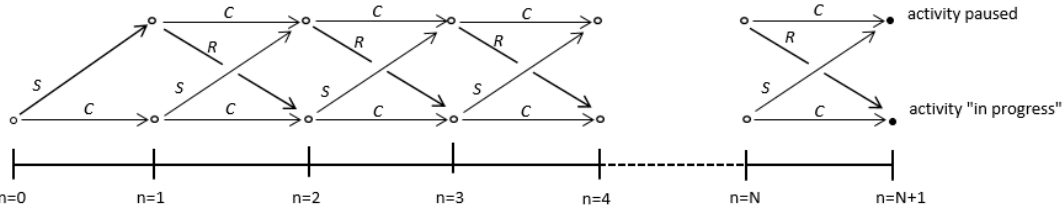
Figure 1. The concept of switching between modes to-mothball and to-reopen production facilities (source: own study).